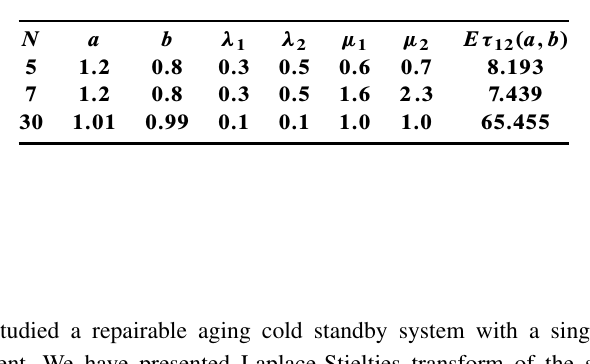
Table 2. Mean time to failure of the system for Gamma distributional